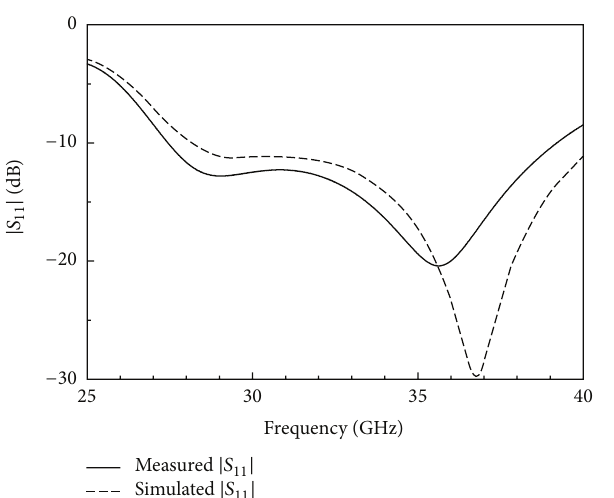
Figure 4: Simulated and measured return loss of the proposed antenna.